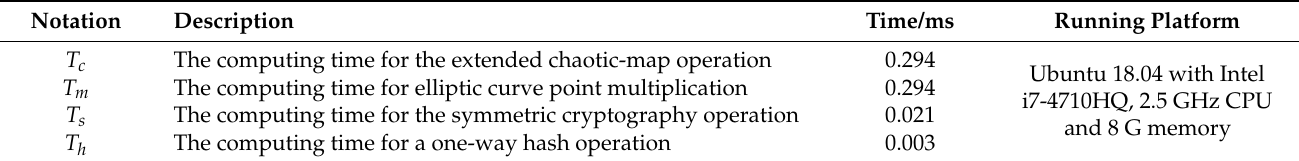
Table 7. Notations with related abbreviations.